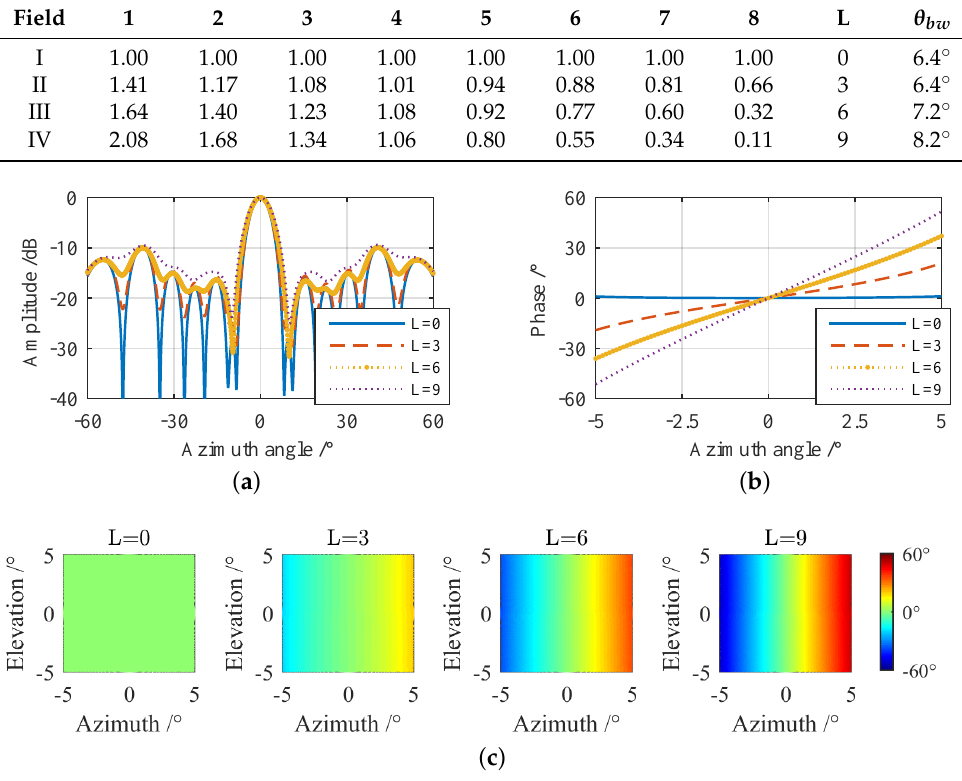
Figure 2. The modulated field constructed by the linear array. The amplitude pattern ( a ) and the phase distributions ( b ) along the azimuth direction (XOZ plane). ( c ) The two-dimensional phase distribution within the main